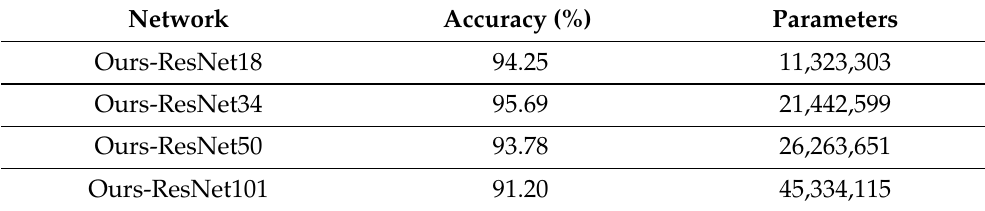
Table 3. Comparison of feature extraction networks for exercise recognition